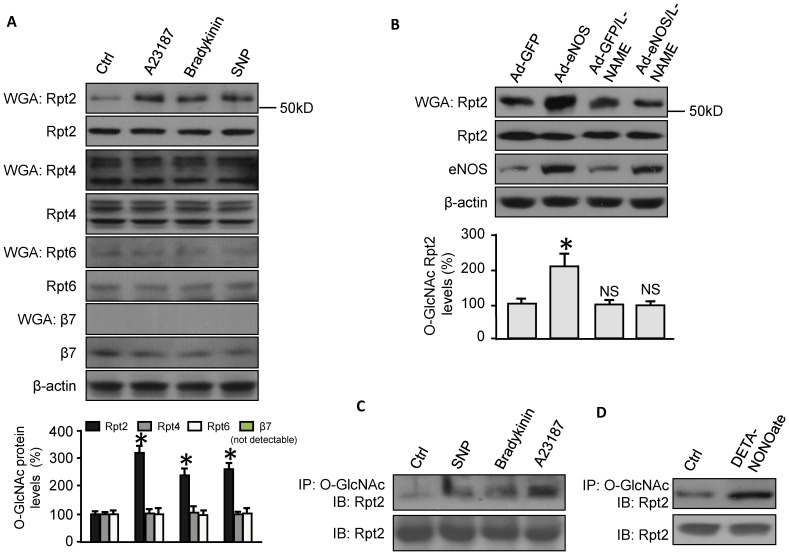
NO increases the O-GlcNAc modification of Rpt2 in endothelial cells.(A) HUVEC respectively treated with A23187, Bradykinin, and SNP presented increased O-GlcNAc modification of Rpt2 without altering total Rpt2 protein levels. (B) Overexpression of eNOS but not GFP upregulated Rpt2 O-GlcNAcylation without changing the levels of total Rpt2 protein. Rpt2 O-GlcNAcylation was detected with the WGA protocol. (C) Confirming Rpt2-GlcNAcylation by repeating experiments in (A) but using an O-GlcNAc antibody (CD110.6) to pull down O-GlcNAcylated proteins. (D) Confirming the effect of NO on Rpt2-GlcNAcylation by repeating experiments in (C) but with DETA-NONOate. The shown blots were representative of at least 3 independent experiments with similar results. * represent p<0.05 vs control (n = 3), otherwise, not significant. Ad-, Adenoviral overexpression; Ctrl, control; SNP, sodium nitroprusside; WGA, wheat germ agglutinin; GFP, green fluorescent protein; eNOS, endothelial nitric oxide synthase.